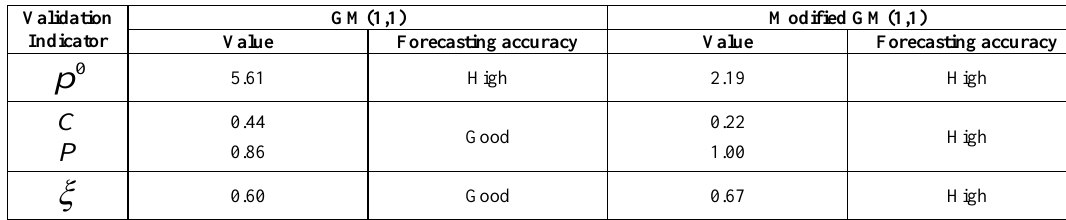
Table 3. The comparison of statistical